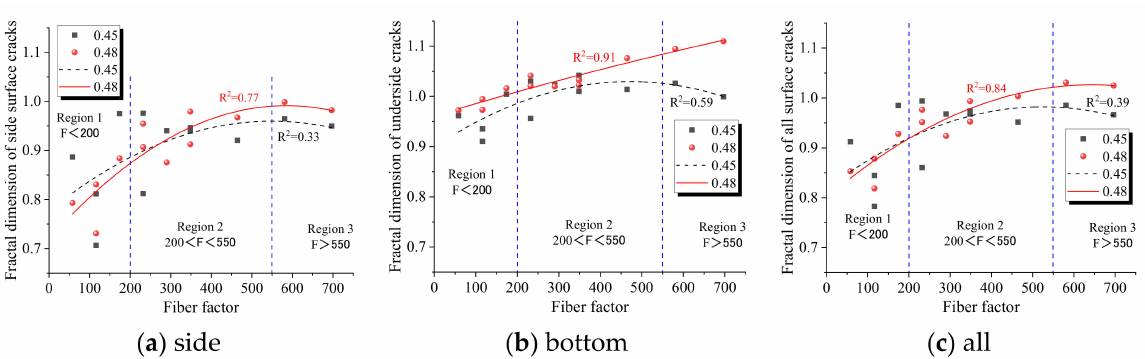
Figure 11. Relationship between fiber factor and crack fractal dimension.